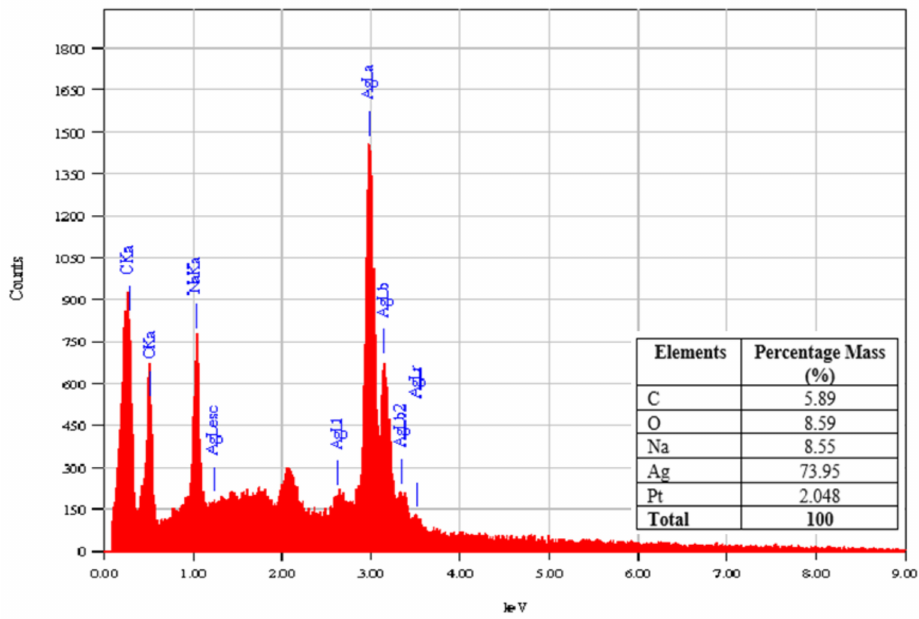
Figure 7. EDX spectrum of AgNP-chi-spheres using 20%